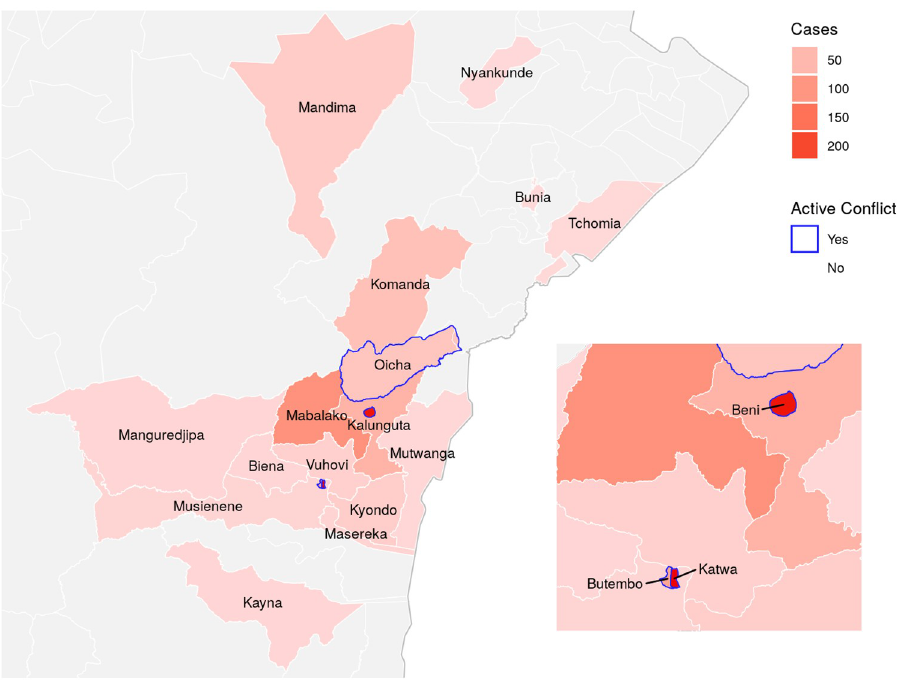
Fig 1. Map of health districts in which confirmed and/or probable cases have occurred in Northeastern DRC. Case counts as of Feb. 25 are indicated by color by district. Districts in which active conflict has occurred as of Feb. 25 are marked by a blue outline. Inset provides magnification and labels for smaller districts. Data sourced from Re´fe´rentiel Ge´ographique Commun [7], made available under the Open Data Commons Open Database License.